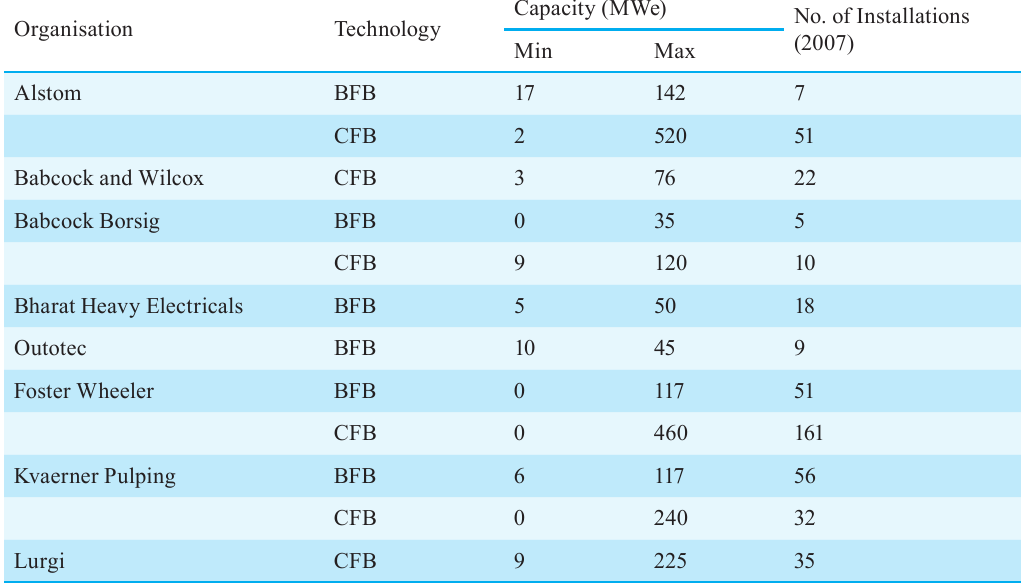
Table 2 Fluidised bed combustion systems. Source: Adapted from Koornneef et al. (2007) Organisation